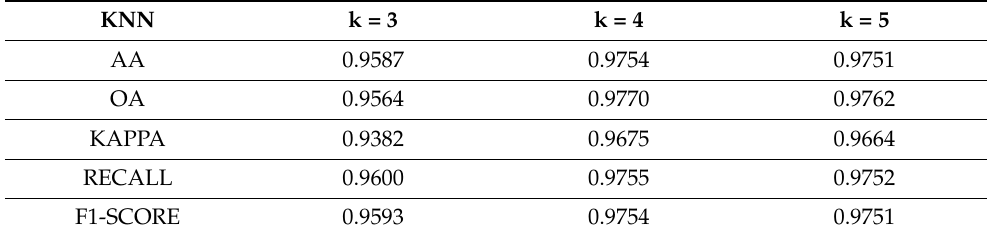
Table 2. Selection of KNN classification